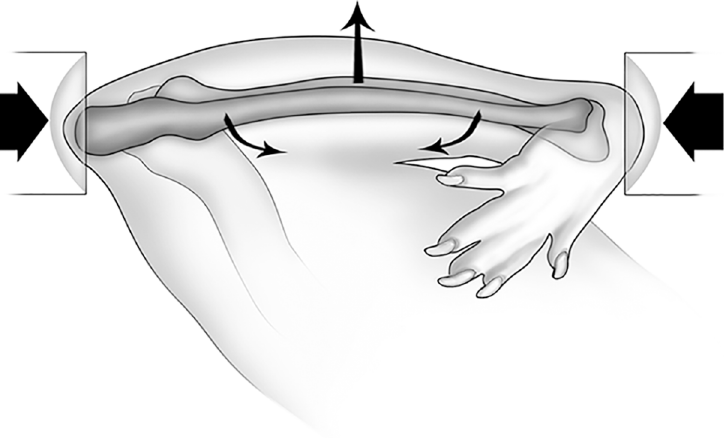
Fig 1. Schematic diagram of the rat ulna end-loading model. The right antebrachium was placed horizontally in loading cups attached to the materials testing machine. The medio-lateral diaphyseal curvature of the rat ulna is accentuated through axial compression, most of which is translated into a bending moment. Reproduced from [42] with permission from John Wiley &